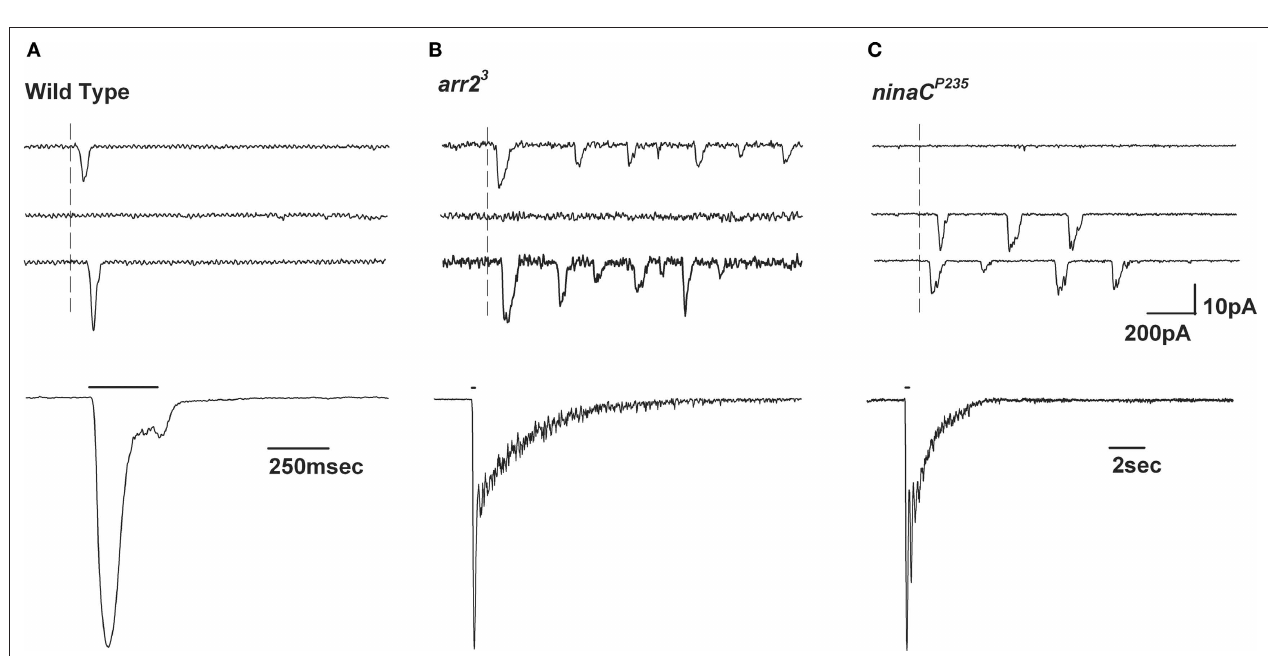
channels, the TRP and TRPL open by a still unknown mechanism. PLC also α bound to GDP and this promotes hydrolysis of the bound GTP, resulting in G q α activity. The TRP and TRPL channel openings ensures the termination of G q α ) by lead to elevation of cellular Ca 2 + . Elevation of DAG and Ca 2 + promote eye- q specifi c protein kinas C activity, which regulates channel activity. PLC, PKC into the soluble InsP and and the TRP ion channel form a supramolecular complex with the scaffolding 2 3 protein